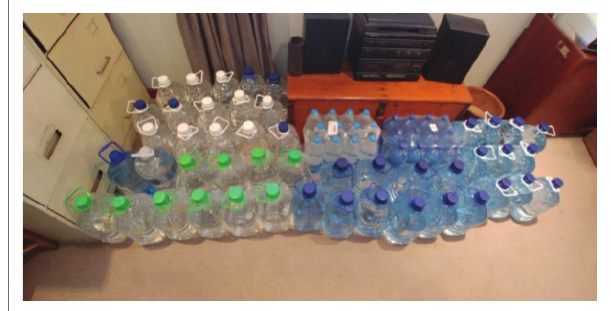
FIGURE 2: Residential hoarding of potable water for a possible ‘Day